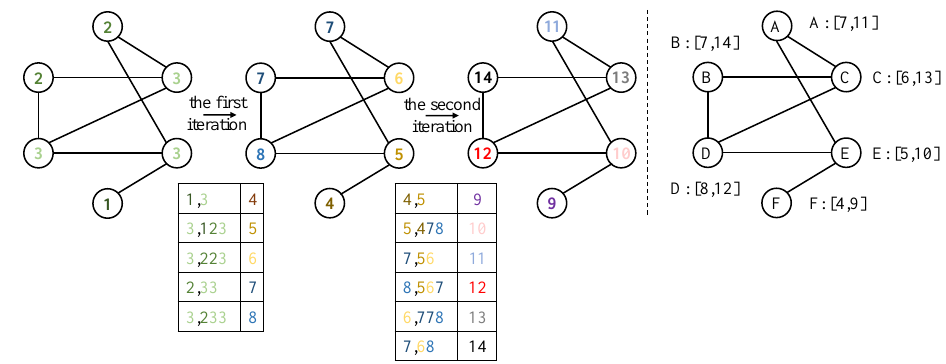
Figure 4. Illustration of generating global structure features based on the WL algorithm. The first iteration is used as an example for illustration. Every node in the first iteration aggregates the label of its neighbour nodes. If two nodes’ aggregated labels are the same, in the next iteration, these two nodes will have the same label. The absolute value of the label is just a symbol, and the number has no